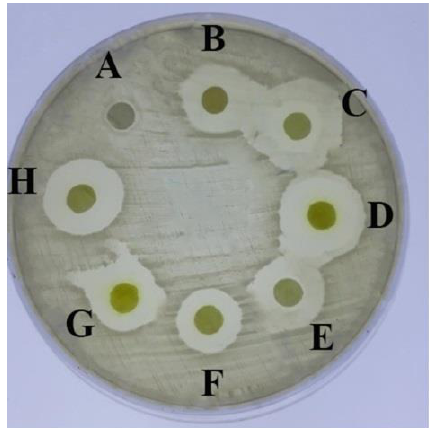
Figure 2. Susceptibility of S. aureus towards bichalcophenes, on Mueller–Hinton agar medium incubated at 37 °C for 24 h. (A) DMSO, (B) MA-1113 , (C) MA-1114 , (D) MA-1115 , (E) MA-1116 , (F) MA-1156 , (G) MA-0944 , (H) MA-0947 . Note: The results expressed as zone inhibition in mm diameter. Assays were performed in triplicate exposing the mean (mean ± SE). Abbreviation: SE, standard error. Table 1. Inhibitory effect of monocationic bichalcophenes on S. aureus . Tested Compound (10